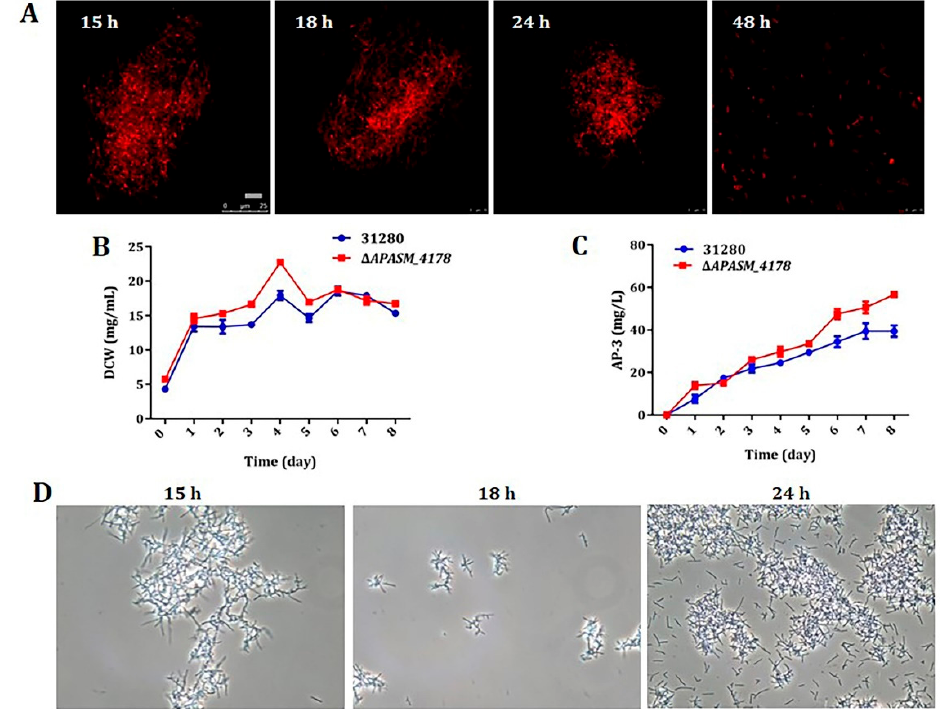
Figure 2. Deletion of subtilisin-like gene APASM_4178 led to delayed mycelial fragmentation, increased growth and AP-3 yield. ( A ) Confocal micrographs of the APASM_4178 -deleted mutant WYT-5. Scale bar: 10 µ m. Magnification, 2500 × ; ( B ) Growth comparison between the wild-type and the mutant WYT-5. Error bars: mean ± SD ( n = 3 biological replicates); ( C ) AP-3 yield comparison between the wild-type and the mutant WYT-5. Error bars: mean ± SD ( n = 3 biological replicates); ( D ) Phase-contrast micrographs of WYT-5 complemented with cloned APASM_4178 . Scale: 5 µ m. Magnification, 400 ×